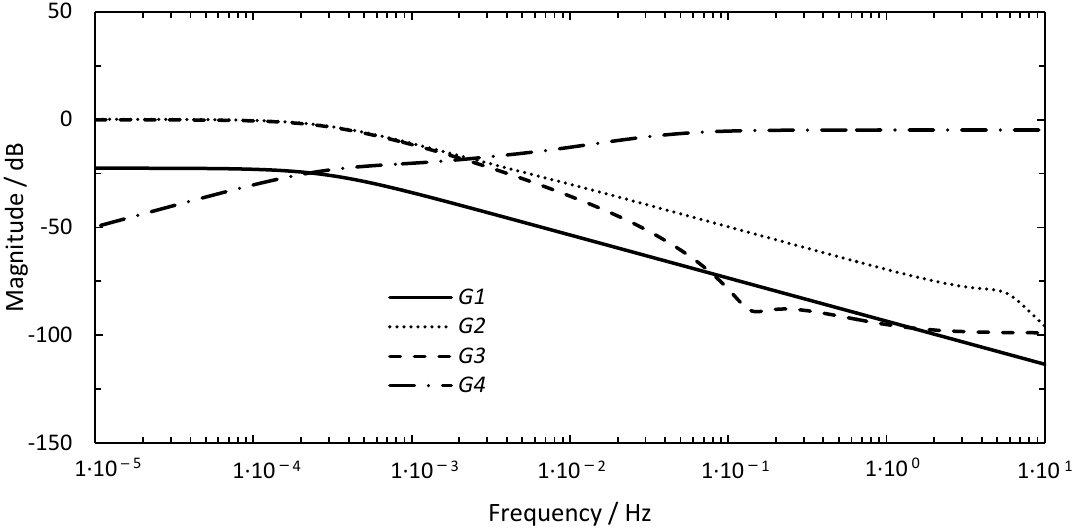
Figure 7. Bode magnitude plot for the four transfer functions G 1 to G 4 . Damped dynamics of the heat transfer system for higher frequencies can be observed.